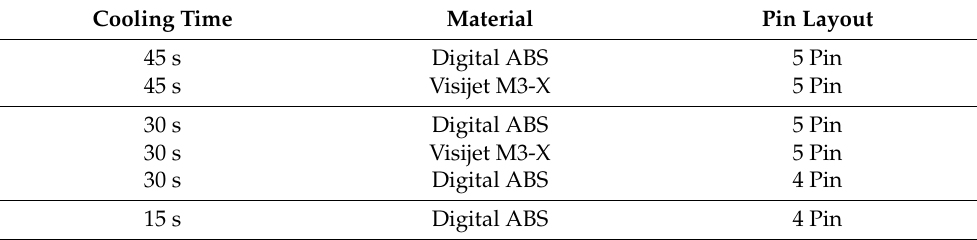
Table 4. List of cooling times, tooling material and pin layout used.